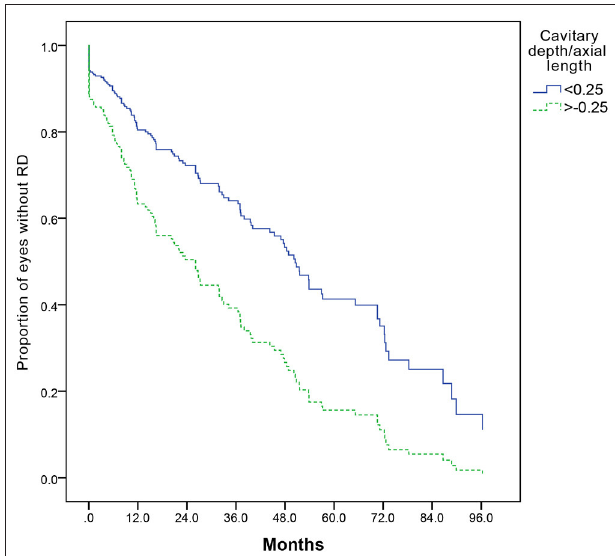
FIGURE 5 | A Kaplan–Meier plot comparing risk of retinal detachment with cavitary depth/axial length more than or equal to, or less than 0.25 ( P = 0.000). A Cox regression analysis, including cavitary depth, cavitary width, relative size of excavation (cavitary depth/axial length, cavitary depth/cavitary width, and product of cavitary depth and width), and the presence of PFV, is performed, and cavitary depth/axial length is the only statistically significant risk factor ( P =